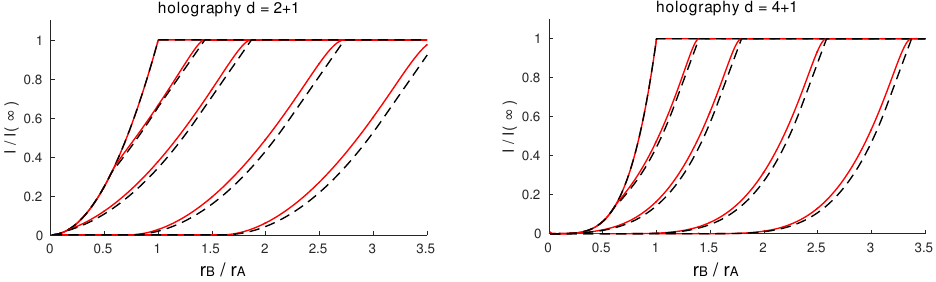
Figure 4 . We plot I [ B R ( t ) ; A L ] as a function of r B =r A . The di(cid:11)erent curves correspond to t=r A = 0 ; 0 : 5 ; 1 ; 2 ; 3. Dashed/black is the lower bound, solid/red is the holographic